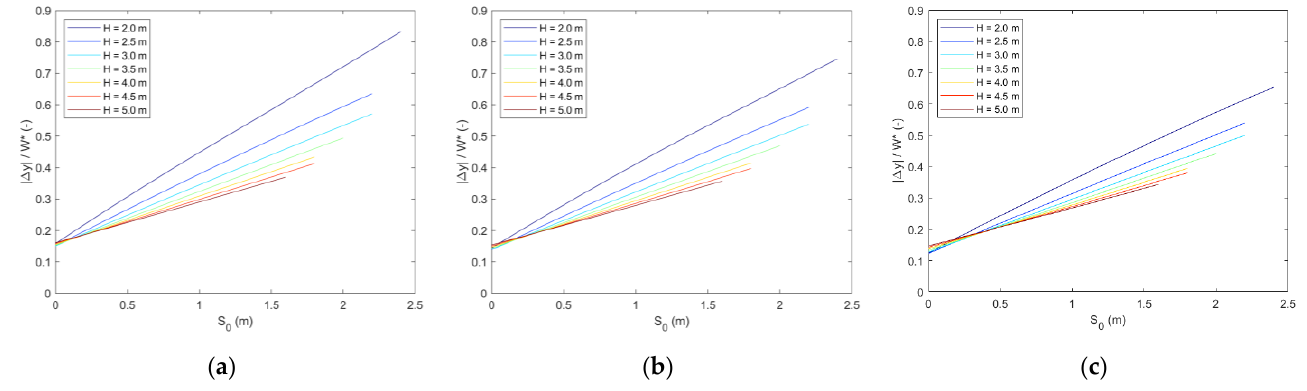
Figure 5. Dimensionless erosion (| Δ y|/W* ) for free beaches with different slopes: ( a ) m = 1/30; ( b ) m = 1/20; ( c ) m = 1/10. ( b ) m = 1/20; ( c ) m =